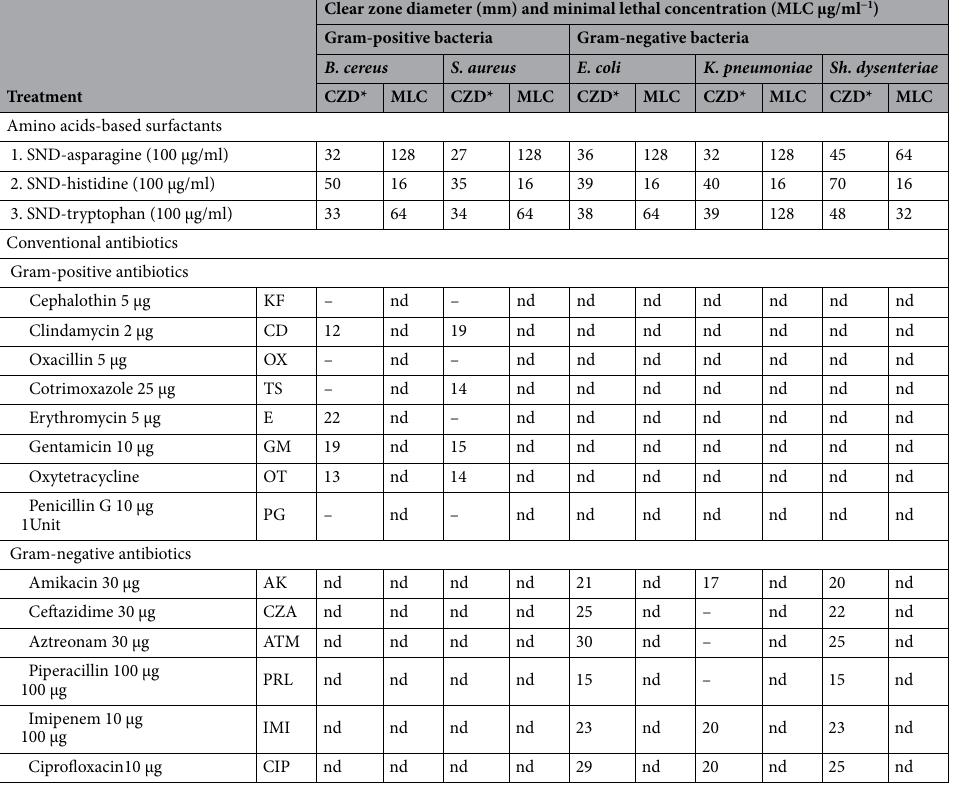
Table 5. Antimicrobial activity of the examined surfactants in comparison to traditional antibiotics against food-born pathogenic bacteria based on the clear zone diameter (CZD a–c , mm), and minimal lethal concentration (MLC, µg/ml). a The values are the mean of the three samples ± SD. b Inhibition zone diameter was measured as the clear area in the center of agar well. c nd not determined, –no effect.